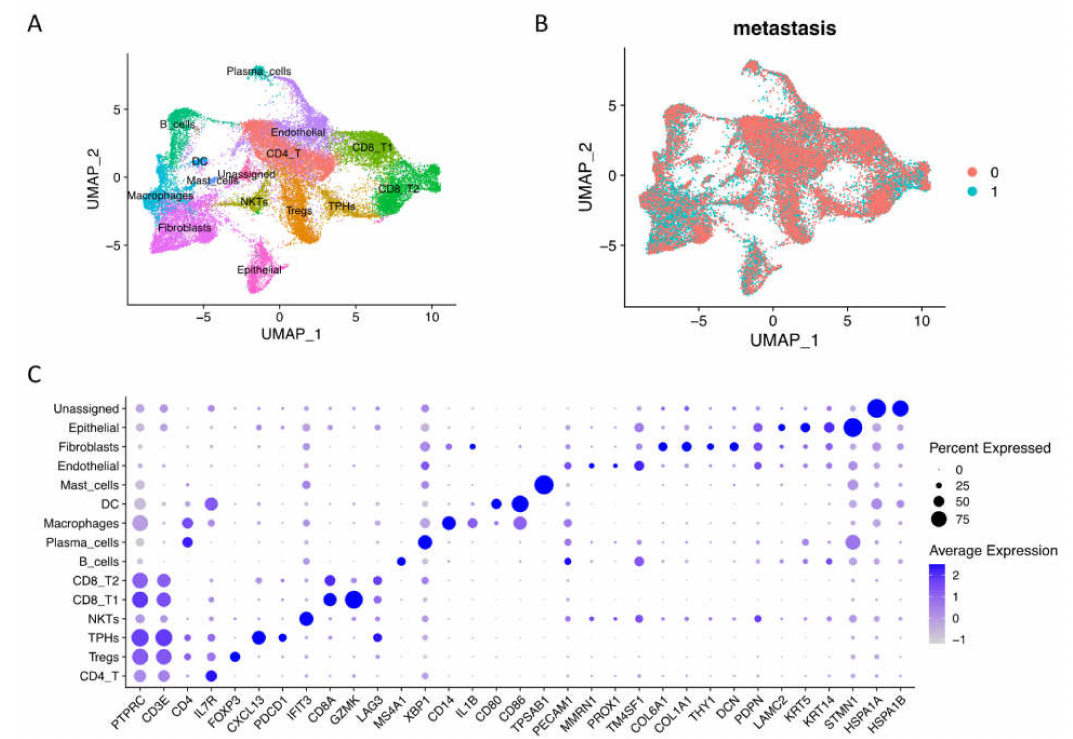
Figure 1. Single-cell RNA-seq integration of oral squamous cell carcinoma data. ( A ) Integrated cells were visualized by UMAP with 15 main cell types assigned names based on canonical markers. ( B ) Integrated scRNA-seq data included 16,817 non-lymph node metastasis cells (0, N0) and 13,183 lymph node metastasis cells (1, N1 to Nx). ( C ) Dotplot of the average expression of the main markers of each cell type in oral squamous cell carcinoma integration